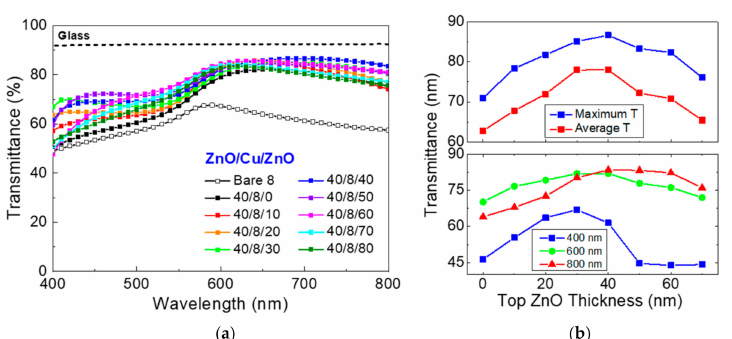
Figure 3. ( a ) Optical transmittance for the ZnO / Cu / ZnO electrodes as a function of incident beam wavelength. Top ZnO layer thicknesses are varied from 0 to 80 nm, with the bottom and Cu layer thickness fixed at 40 nm. The transmittance of bare Cu layer (8 nm) is included for comparison. The air baseline was taken and the transmittance of bare glass is also given as reference. ( b ) (upper panel) Maximum and average transmittance for the ZnO / Cu / ZnO electrodes are given as a function of top ZnO layer thickness. (lower panel) The transmittance evaluated at the wavelengths of 400, 600 and 800 nm are given, respectively, as a function of the top ZnO thickness.